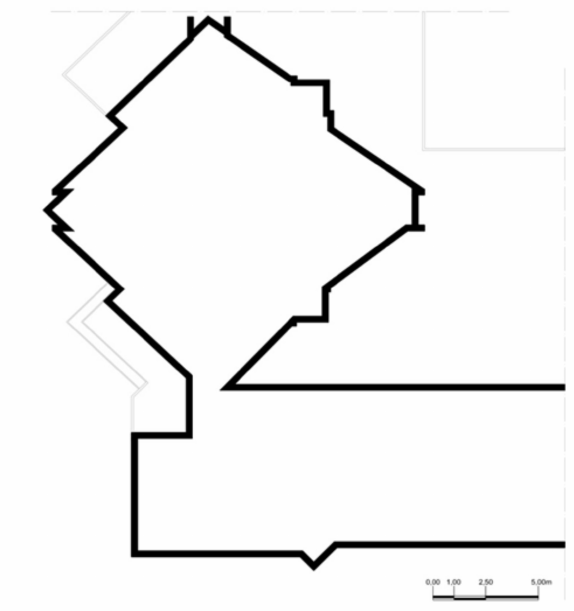
Figure 5. Plan of the Roof